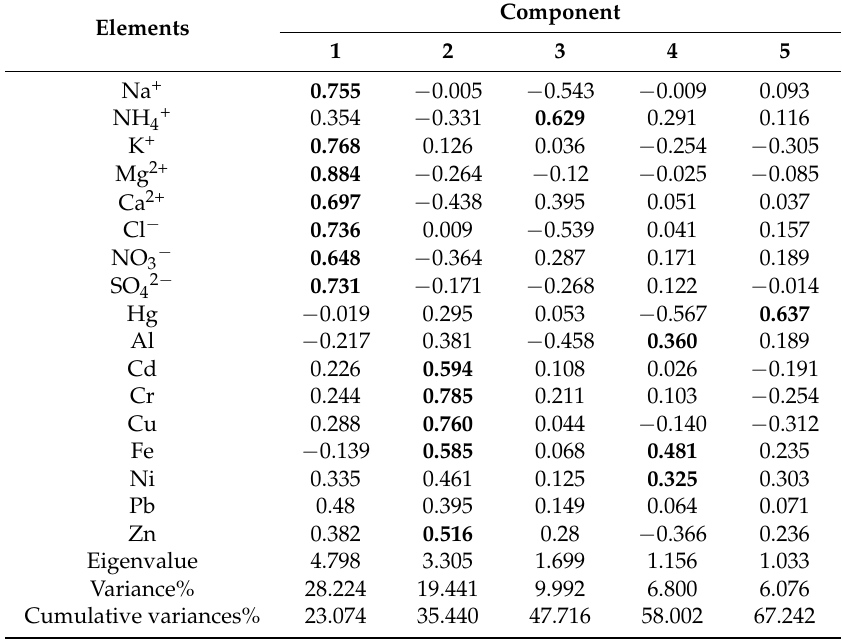
Table 4. Analysis and statistics of the main components of atmospheric settled dust in